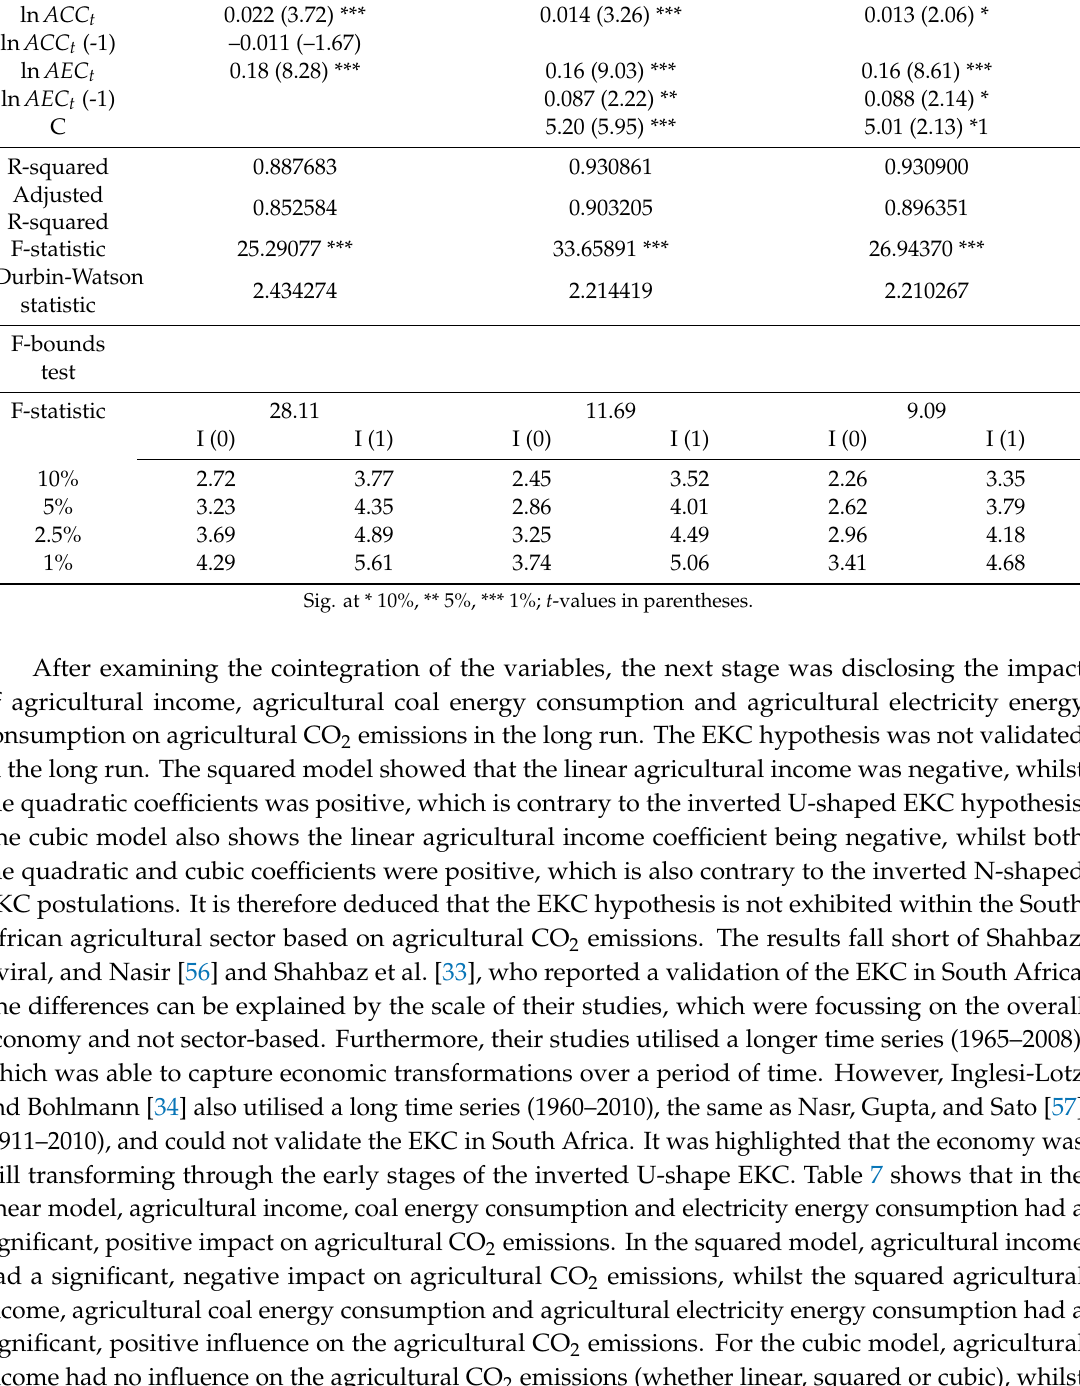
Figure 6. CUSUM and CUSUM of squares test for the squared